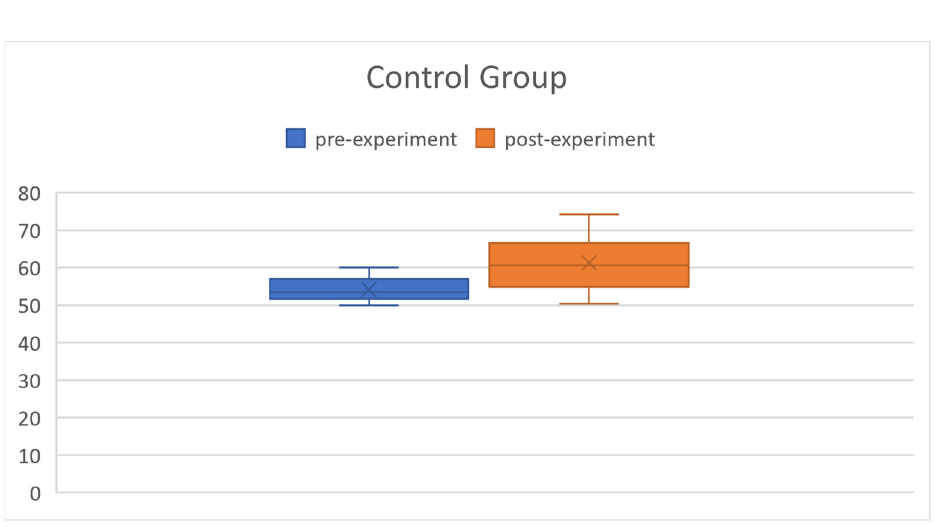
Figure 11. Pre ‐ experiment and post ‐ experiment data of the control group.